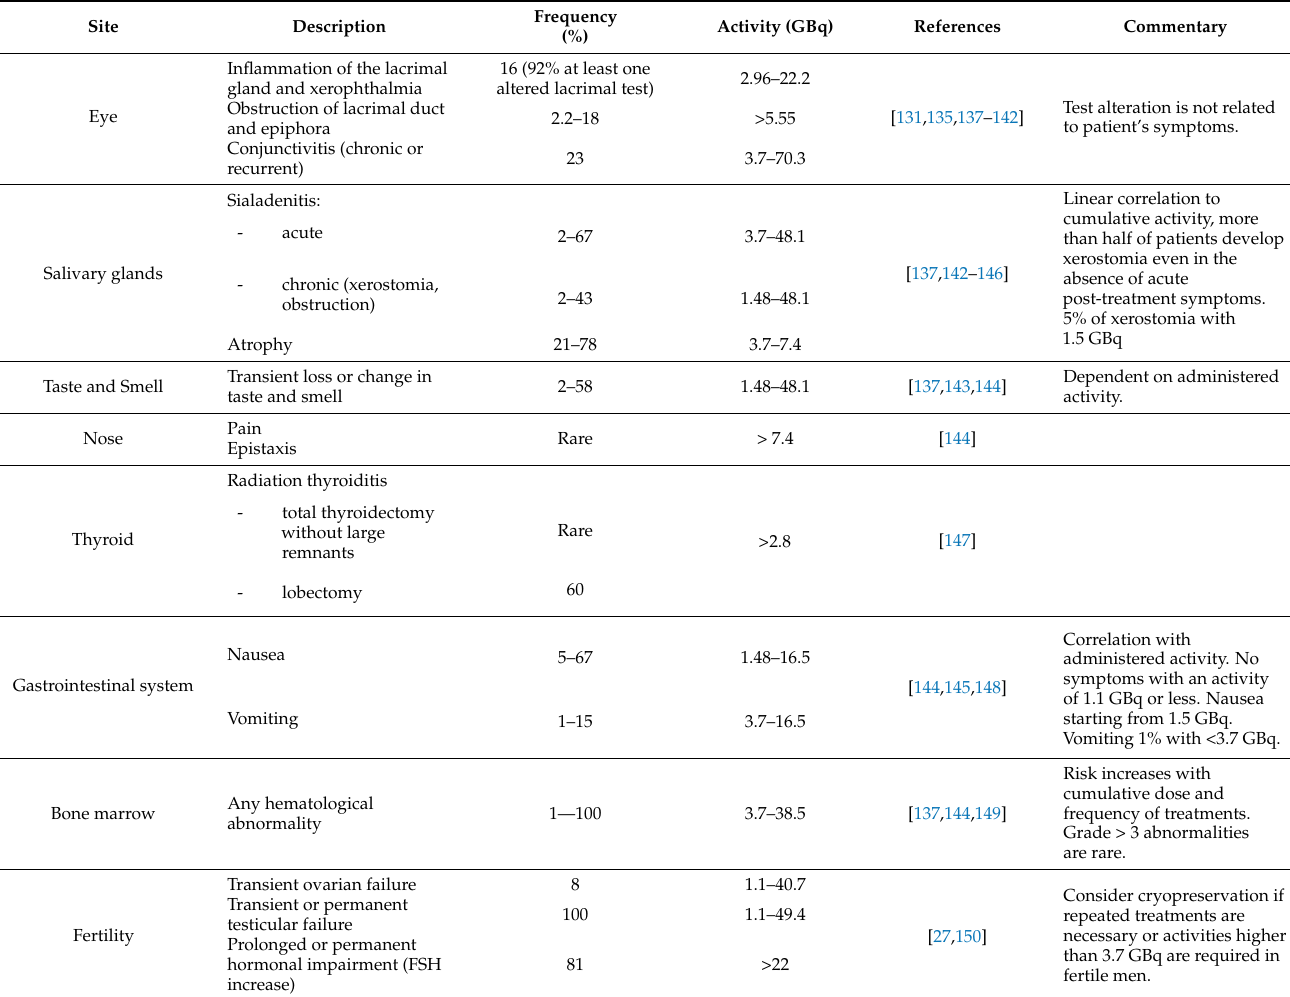
Table 5. Summary of radioiodine side